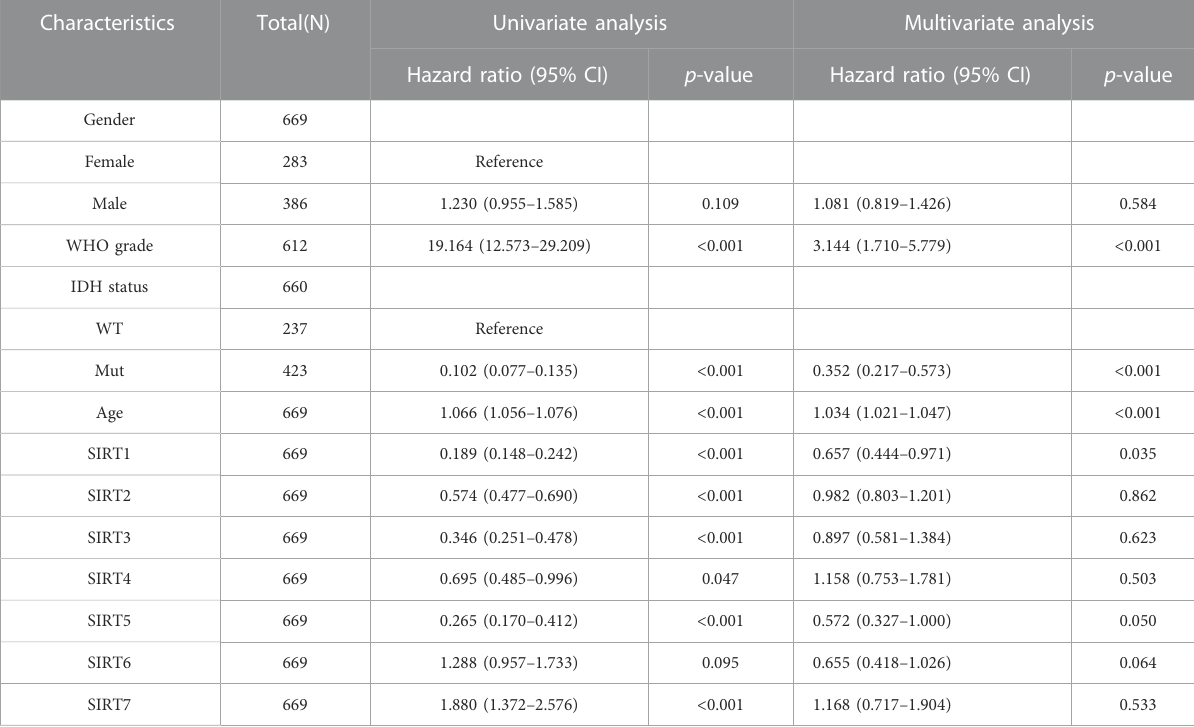
TABLE 1 SIRT family and clinical characteristics as analyzed by OS-based univariate and multivariate Cox regression in the TCGA database.